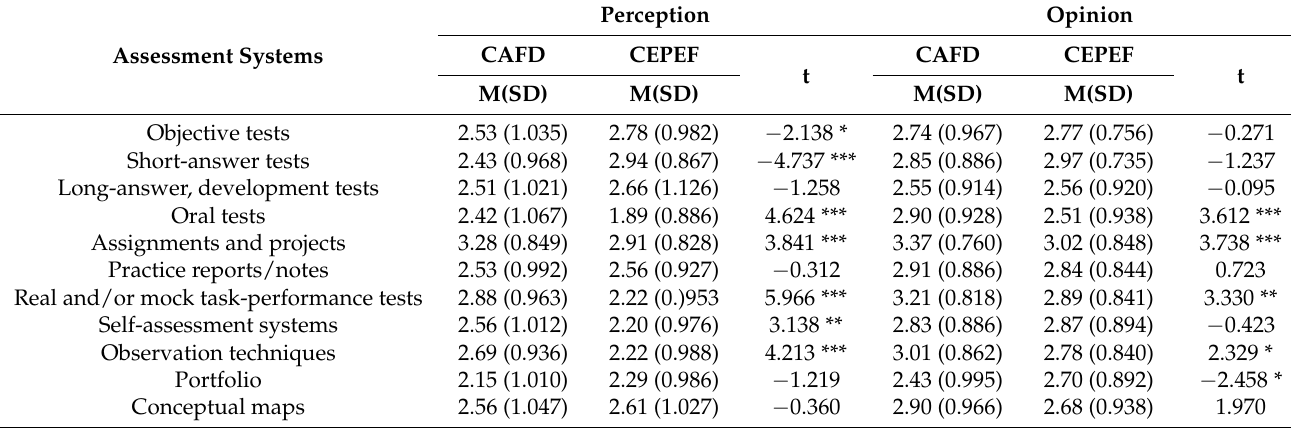
Table 5. Comparison of the perception and opinion on the assessment systems as a function of degree studied.